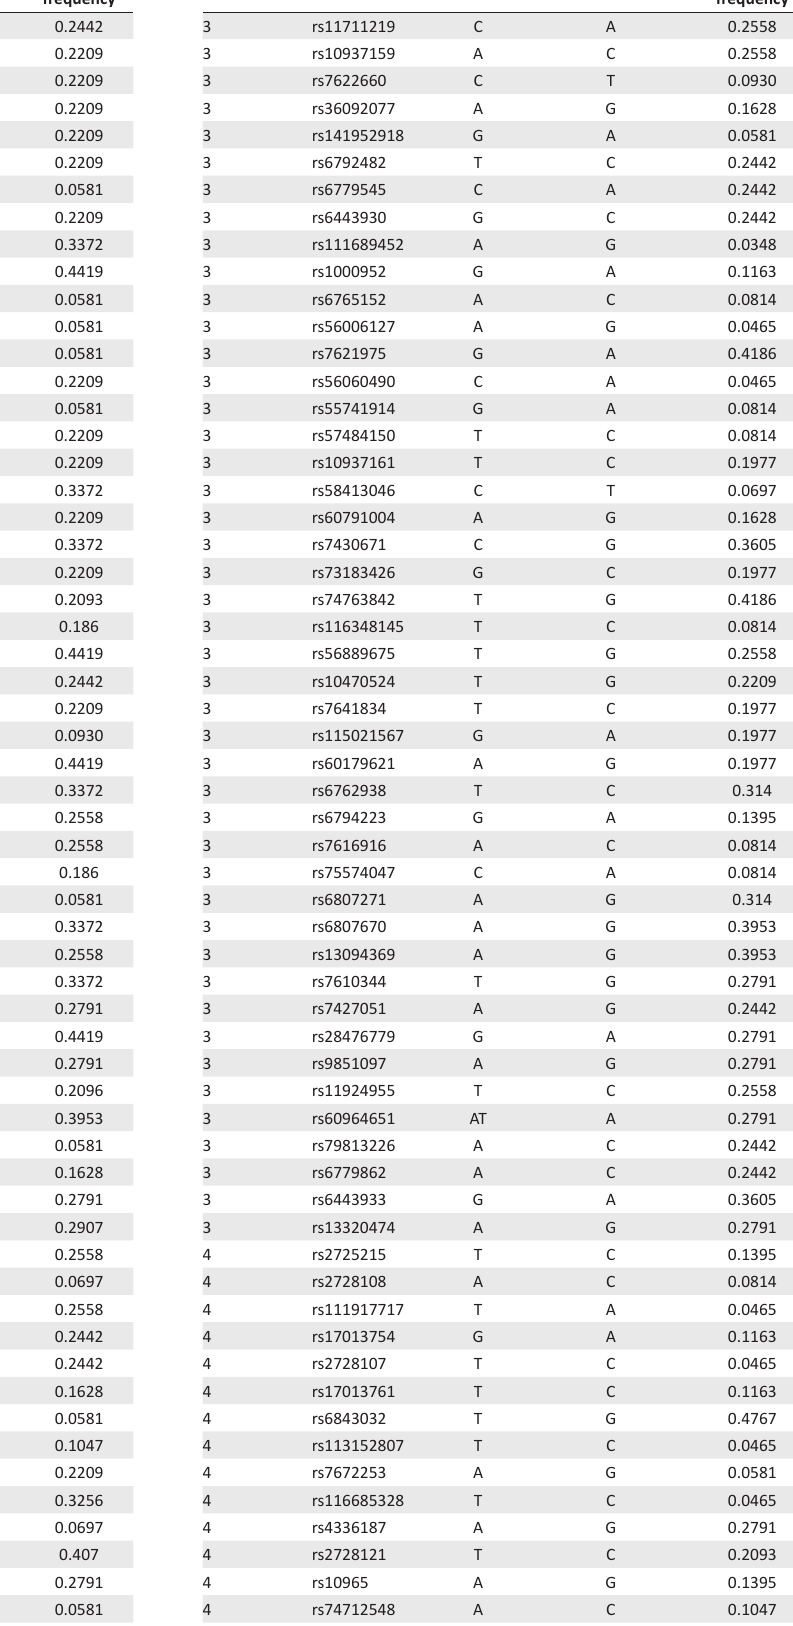
Table 1-A1 (Continues...): Minor allele frequencies for 1846 polymorphisms in 43 black South Africans. Chromosome Polymorphism Minor allele